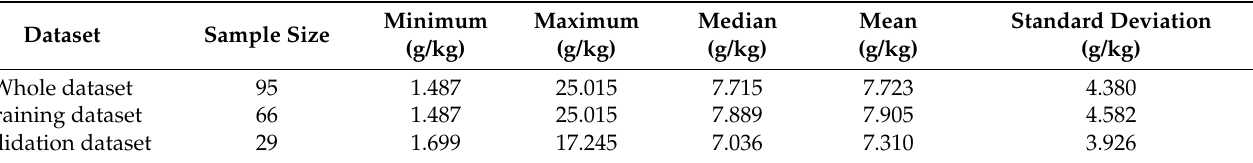
Table 6. Descriptive statistics for the entire SOC dataset, the training dataset and the validation